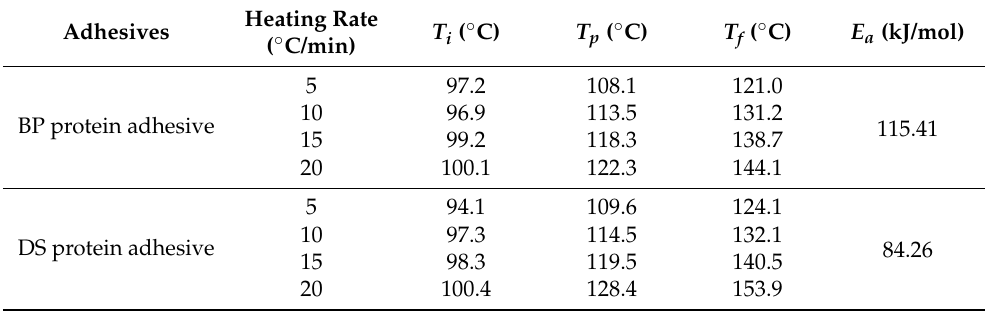
Table 1. DSC result parameters.